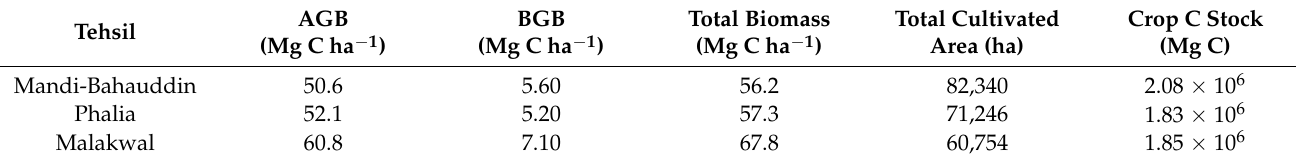
Table 7. Measured Carbon stock in Triticum aestivum